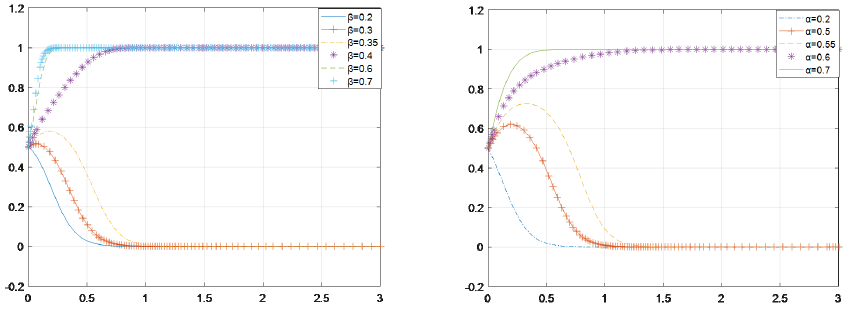
Fig. 6 The influence of α and β on the shared strategy of